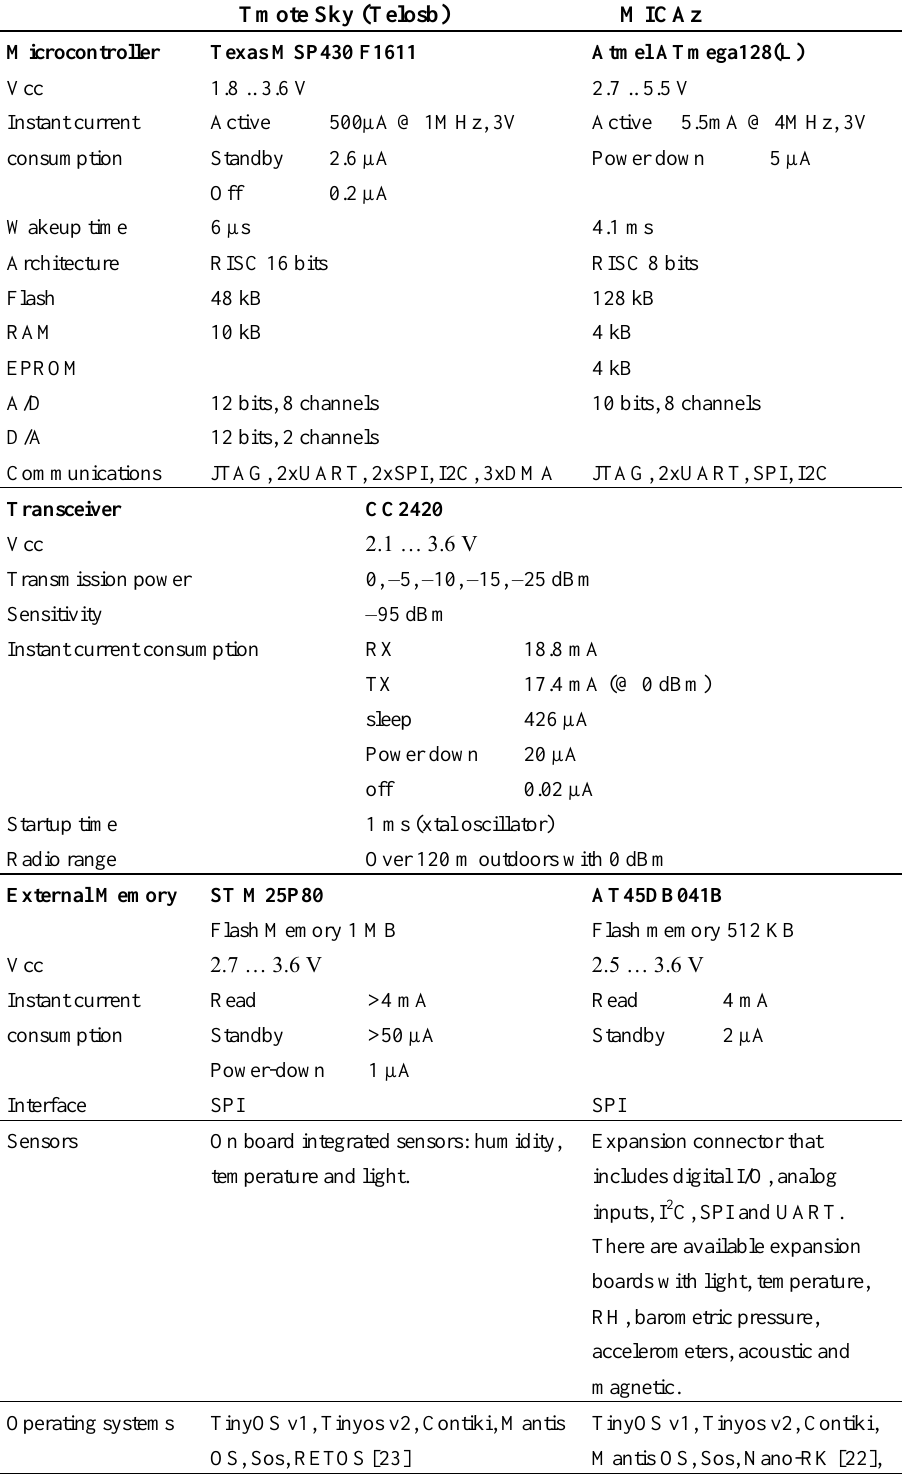
Table 2. Main properties of Tmote Sky (Telosb) and Micaz